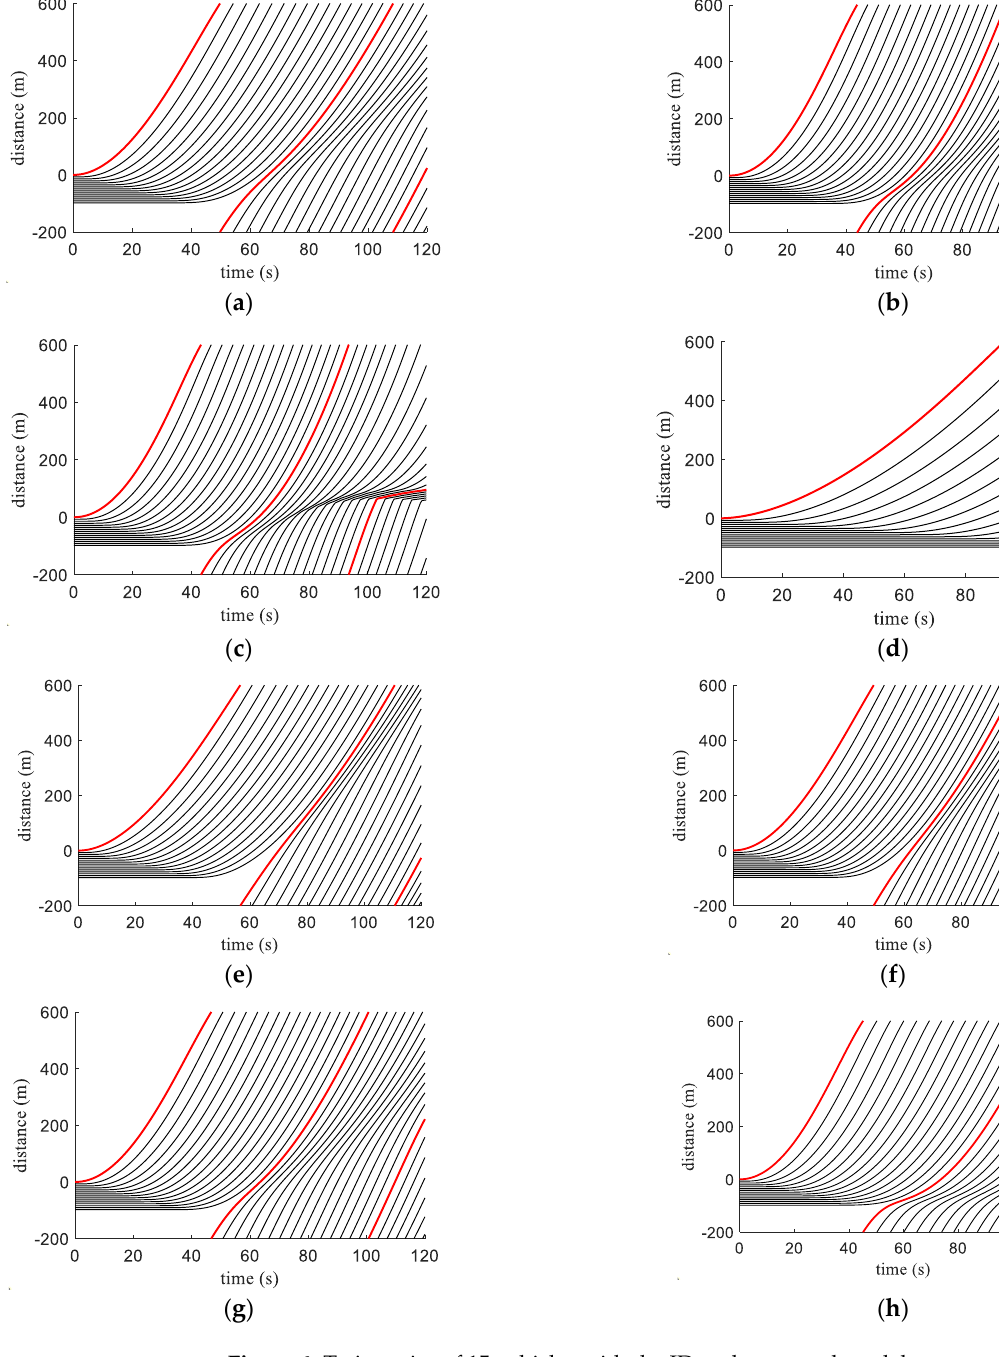
Figure 6. Trajectories of 15 vehicles with the ID and proposed models over a circular road of length 800 m: ( a ) ID model, δ = 1; ( b ) ID model, δ = 4; ( c ) ID model, δ = 20; ( d ) proposed model, T = 0.1 s; ( e ) proposed model, T = 0.5 s; ( f ) proposed model, T = 1 s; ( g ) proposed model, T = 1.6 s; ( h ) proposed model, T = 2.7